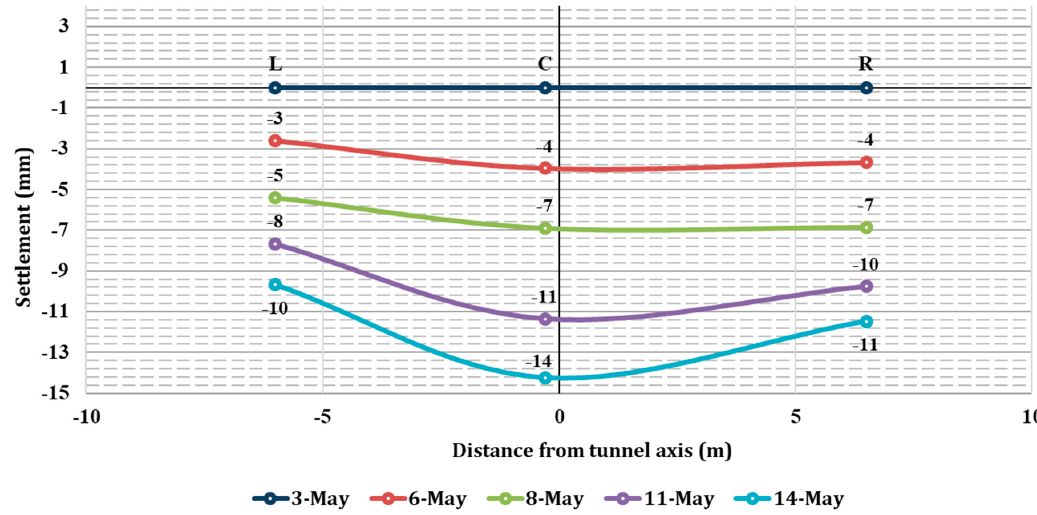
Figure 4. The se tt lement pro fi le at section 2278 m. Figure 4. The settlement profile at section 2278